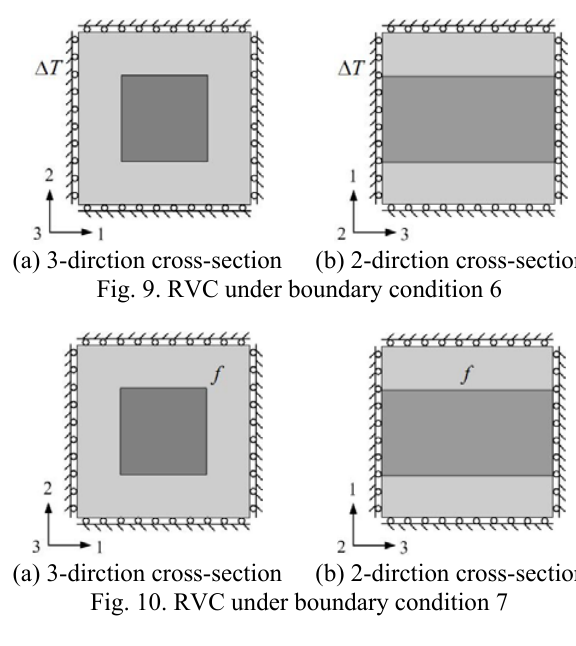
and refer to the strain energy of RVC under boundary condition 6 and 7, respectively.